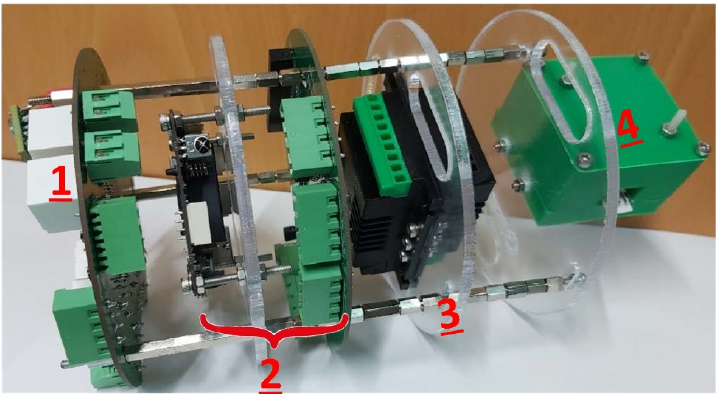
Figure 4. Control cylinder components: power supply board (1), main controller board (2), motor drivers (3), and compass (4).